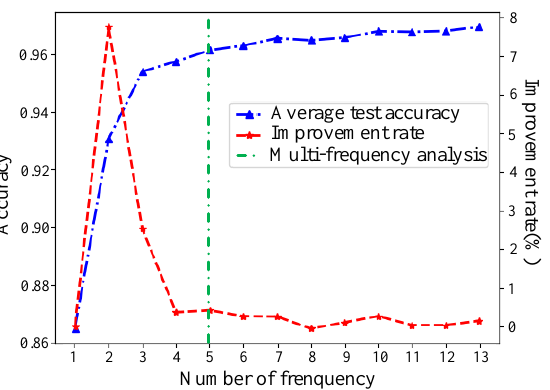
Figure 20. Accuracy and performance improvement rate of variable numbers of multi-frequency after fusing.